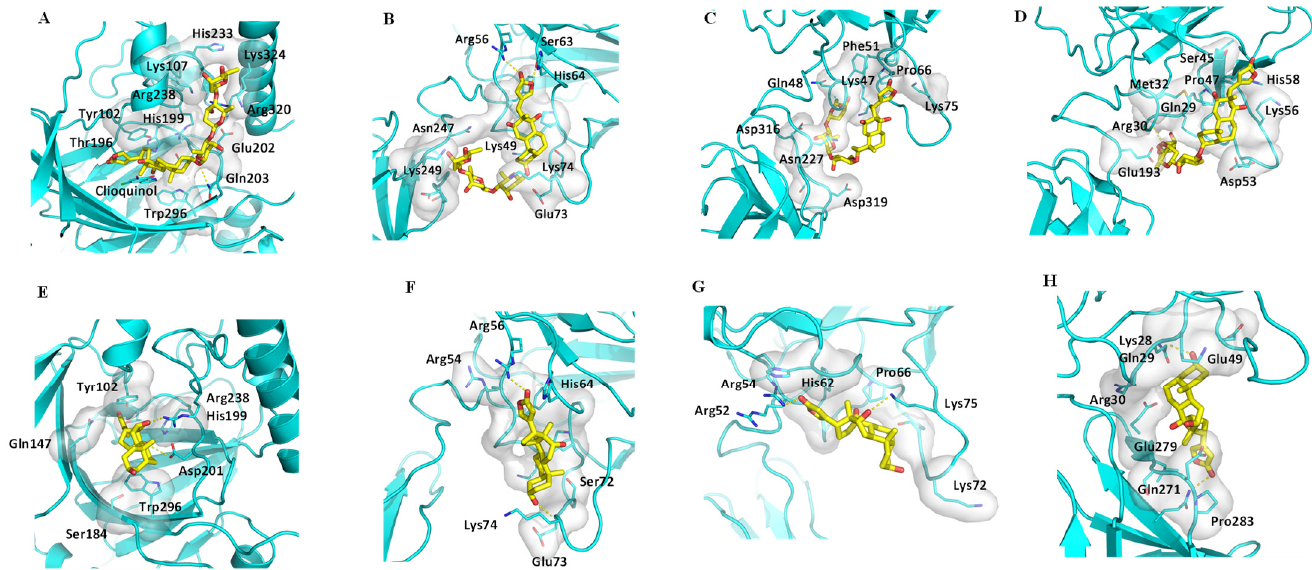
Figure 4. Docking profiles for digoxin ( 2 , yellow) and FIH-1 ( A ) and the subunits p50 ( B ), p52 ( C ), and p65 ( D ) of NF- κ B; and for digoxigenin ( 10 , yellow) and FIH-1 ( E ) and the subunits p50 ( F ), p52 ( G ), and p65 ( H ) of NF- κ B. Digoxin ( 2 ) can bind to FIH-1 and the subunits p50 and p65 of NF- κ B, but digoxigenin ( 10 ) cannot.